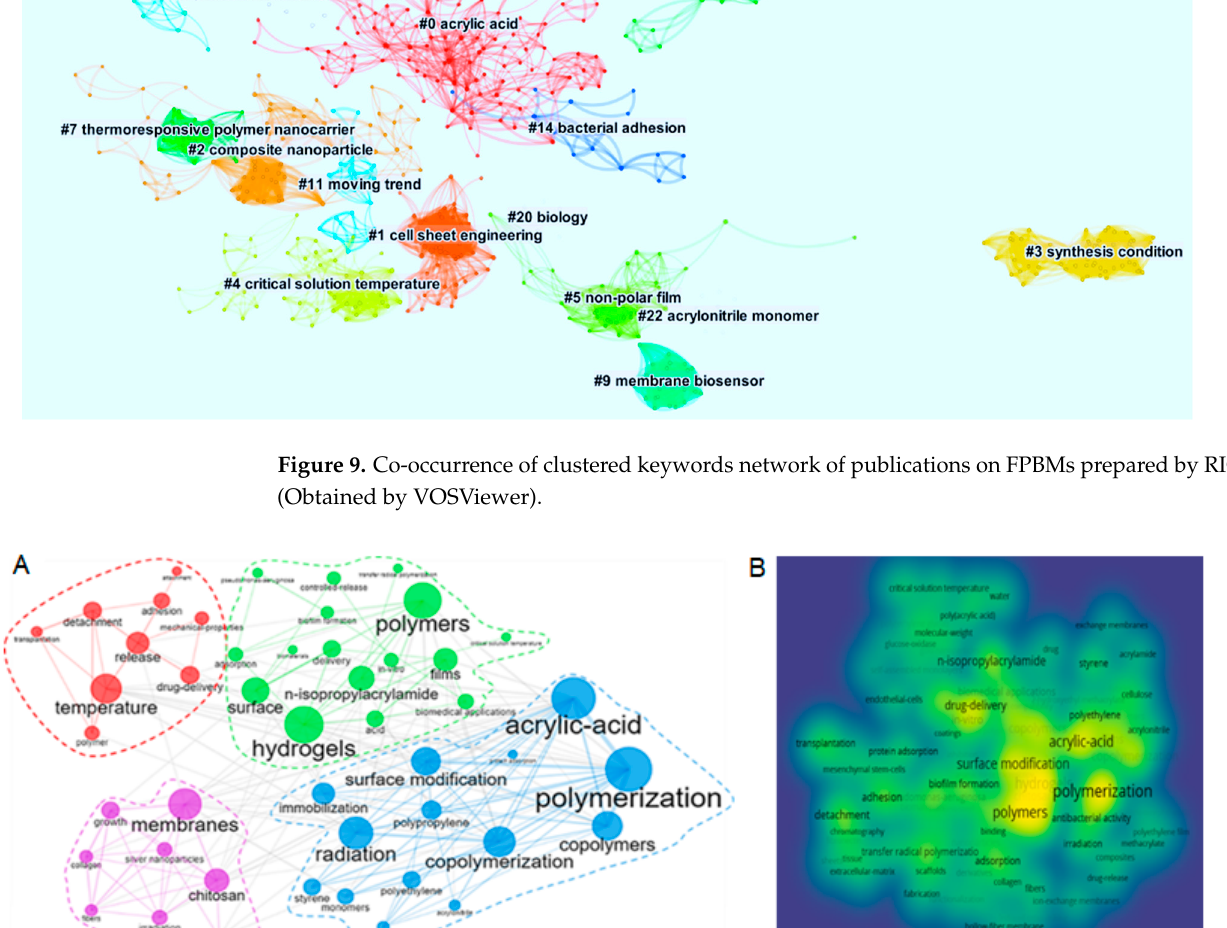
Figure 9. Co-occurrence of clustered keywords network of publications on FPBMs prepared by RIGC. (Obtained by VOSViewer).